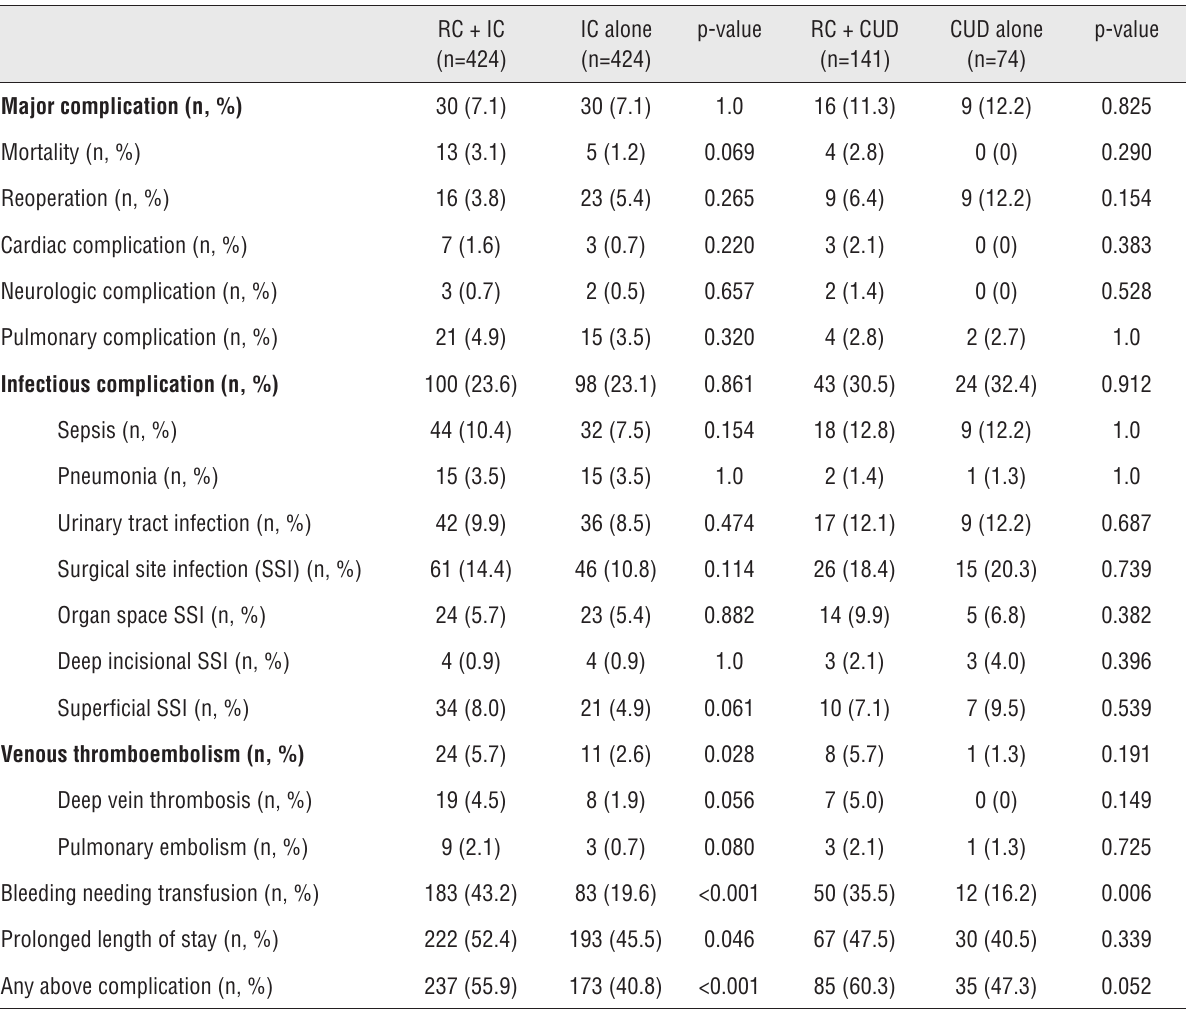
Supplemental Table 1 - Rates of complications after propensity score matching – Comparison of RC + Urinary Diversion to Urinary Diversion